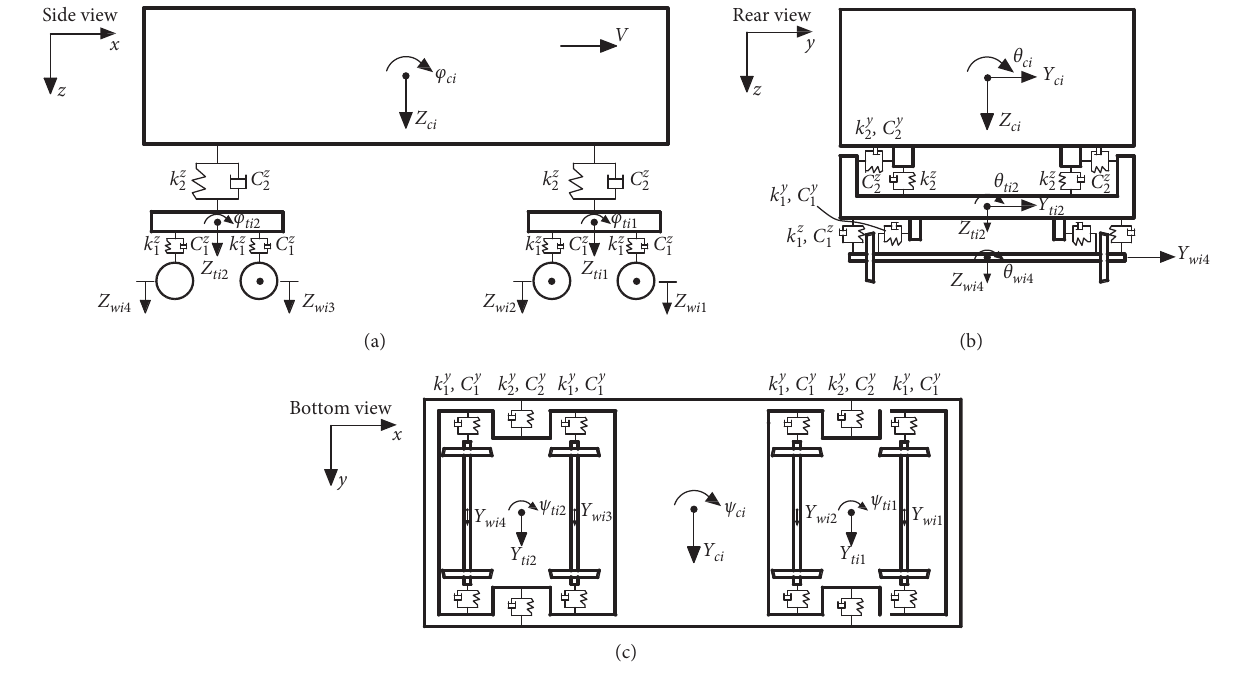
Figure 2: Dynamic model of freight train element.